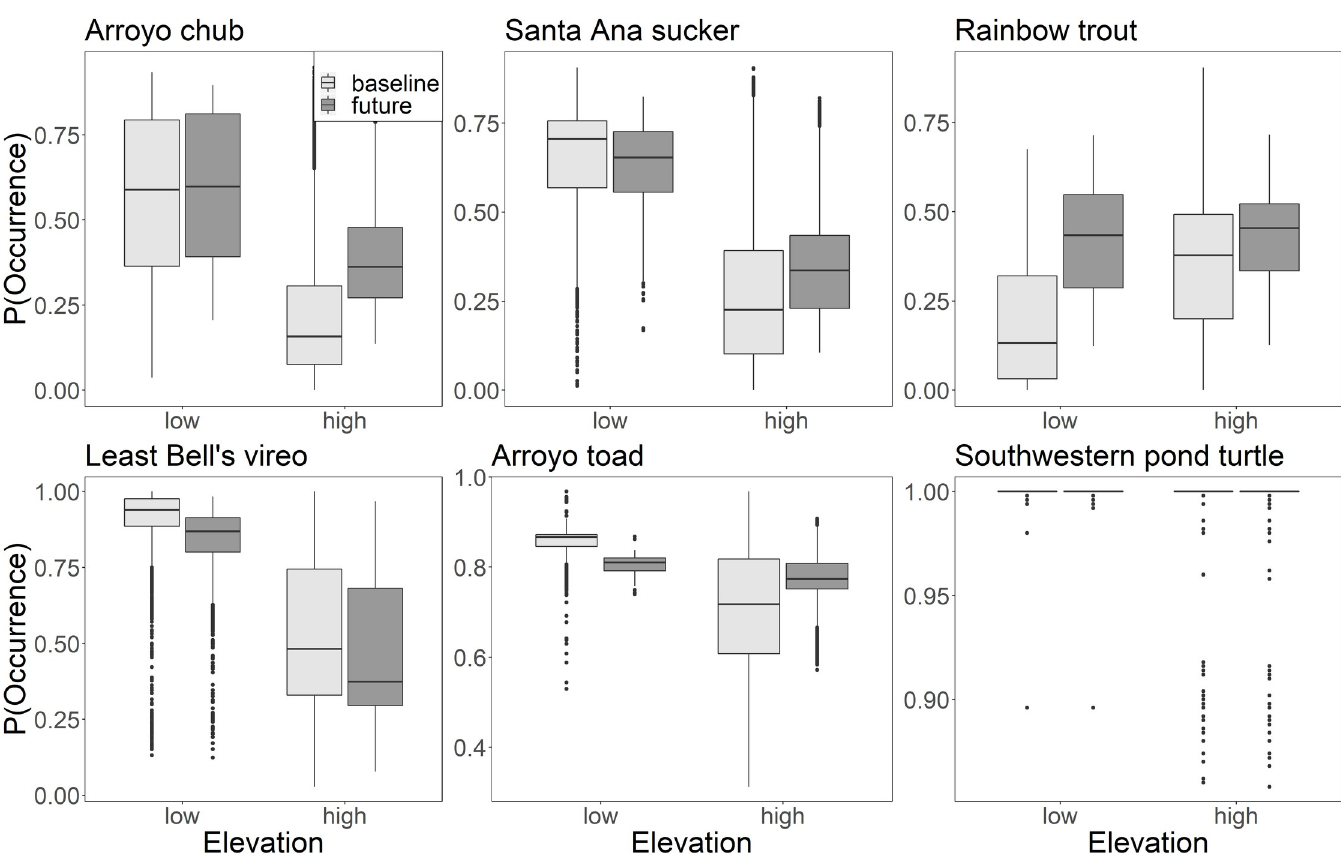
Fig 4. The distribution of probability of occurrence for the regional stream reaches (including all the stream reaches in the region) due to streamflow in the baseline (light grey) and the end-of-century (dark grey) for low ( < 375m) and high ( > 375m) elevation streams. Table 4 shows the change in the different water year types. Boxplots show the 25 th and 75 th percentiles, and 1.5 � the inter-quartile range at the upper and lower end. Points beyond the ‘whiskers’ represent outliers.